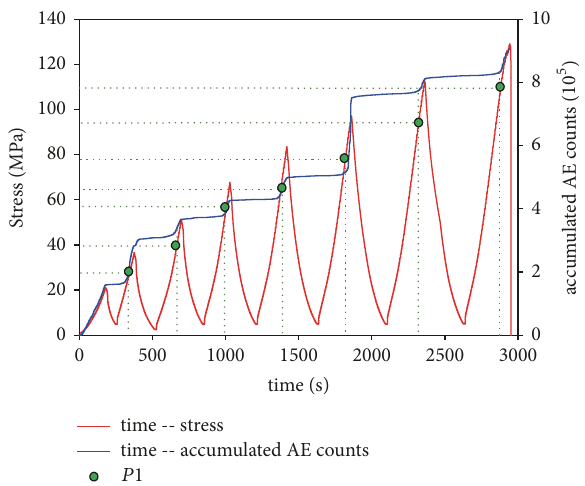
Figure 12: The stress corresponding to the significant acoustic emission that occurred in the repeated loading